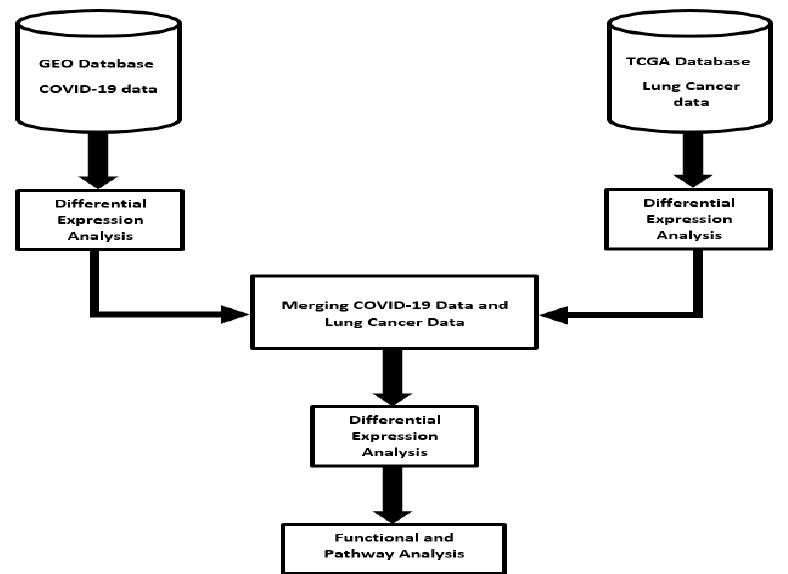
Figure 1. Project design and integrated data analysis workflow of gene expression data from COVID-19, lung cancer and normal lung samples. RNA-Seq data sets were downloaded from the Gene Expression Omnibus (GEO) and The Cancer Genome Atlas (TCGA).